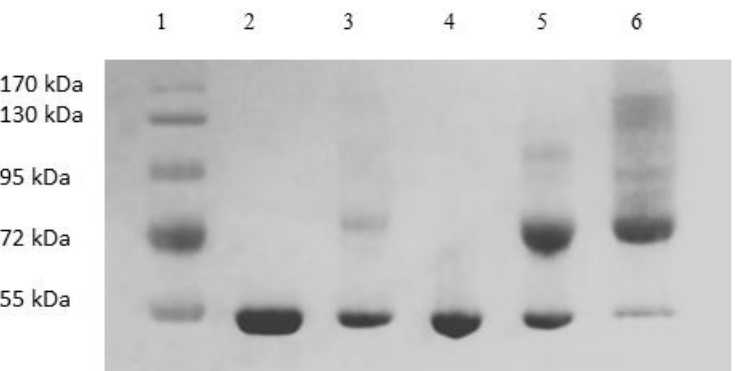
Figure 9. Image of Coomassie-blue-stained SDS-PAGE gel of samples obtained by tangential flow- based hybrid separation (lane 1: MW markers, lane 2: HSA, lane 3: PEG reaction mixture, lane 4: peak 1 (1.65 M flow-through), lane 5: peak 2 (1.5 M eluate), lane 6: peak 3 (0 M eluate)).